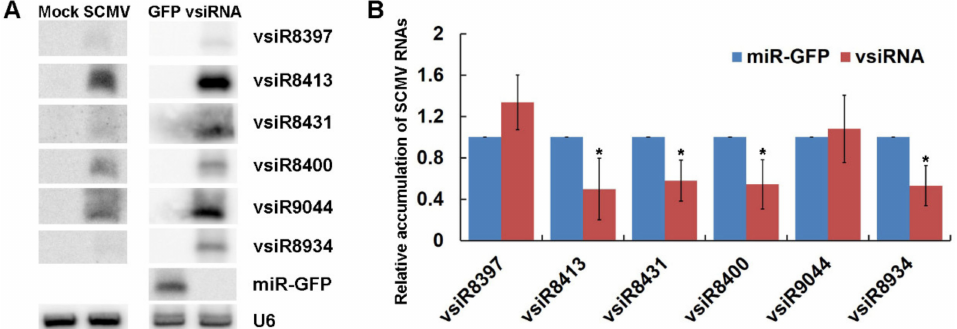
Figure 6. The expressed vsiRNAs could silence SCMV RNAs in maize protoplasts. ( A ) The accumulation of vsiRNAs was determined by Northern blotting in SCMV-inoculated maize plants and in maize protoplasts co-expressed with SCMV RNAs. Mock and SCMV indicated Mock- and SCMV-inoculated maize plants, respectively. GFP and vsiRNA indicated the maize protoplasts expressed miR-GFP and vsiRNAs, respectively. U6 was used as a loading control. ( B ) The relative accumulation of SCMV RNAs in maize protoplasts was determined by qRT-PCR when co-expressed miR-GFP or vsiRNAs. Three independent experiments were conducted with at least three biological replicates and the data were analyzed using a two-sample t -test. Bars represent the grand means ± SD. “*” indicate a significant difference ( p -value <